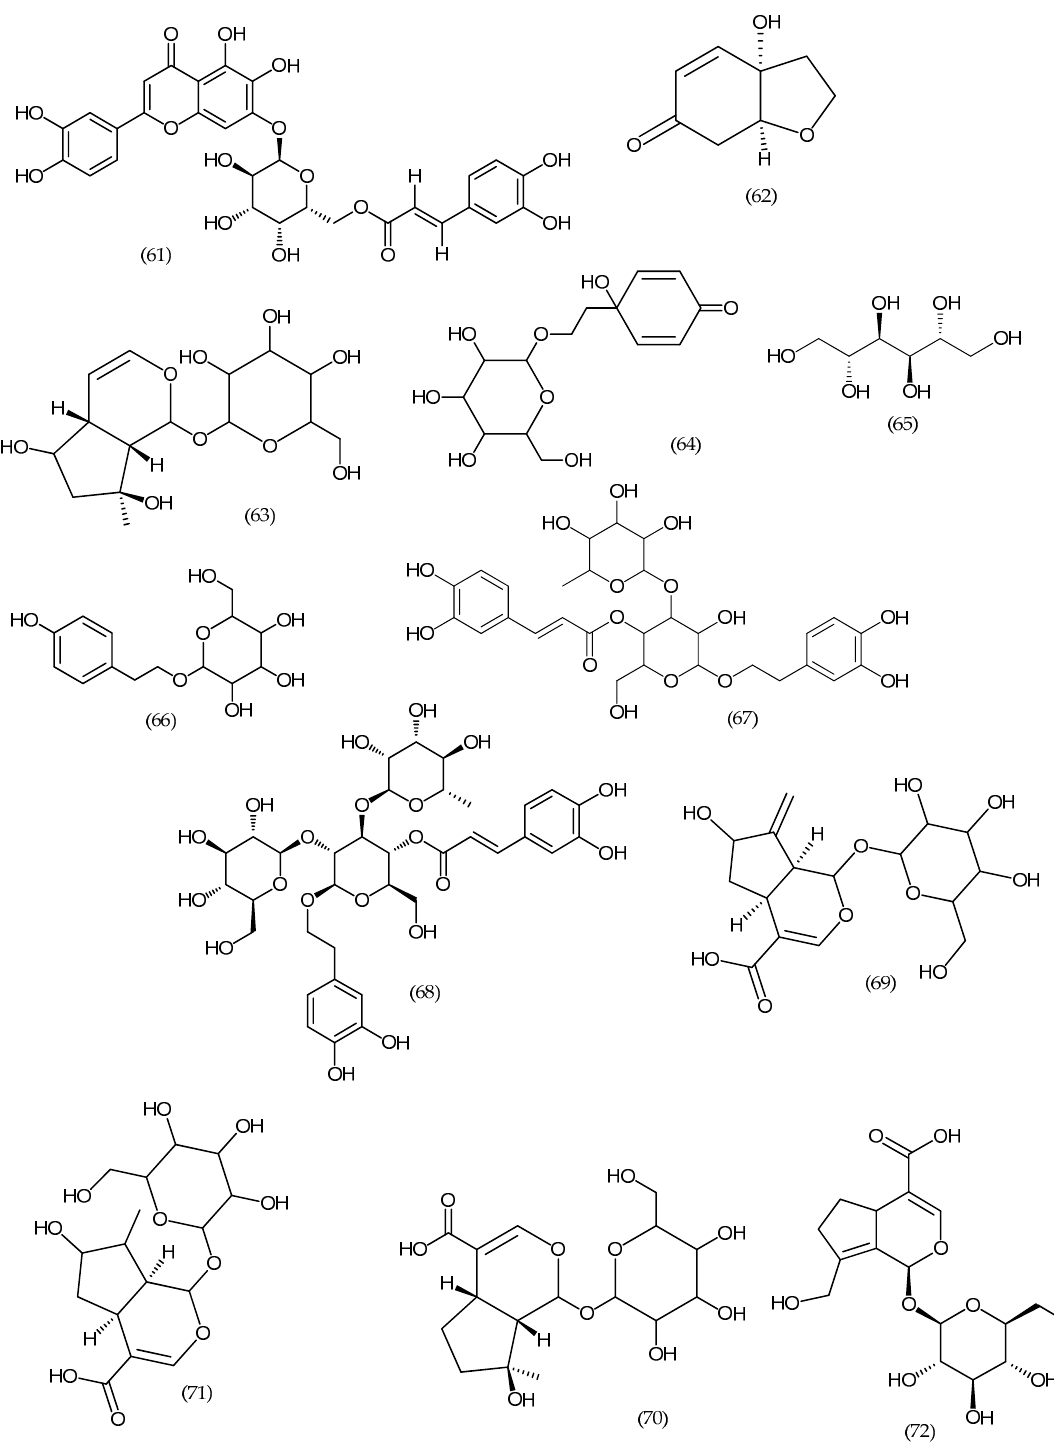
Figure 11. Phytoconstituents reported in Veronica arvensis and other species (Table 2). 2.11. Veronica Turrilliana Stoj. & Stef.